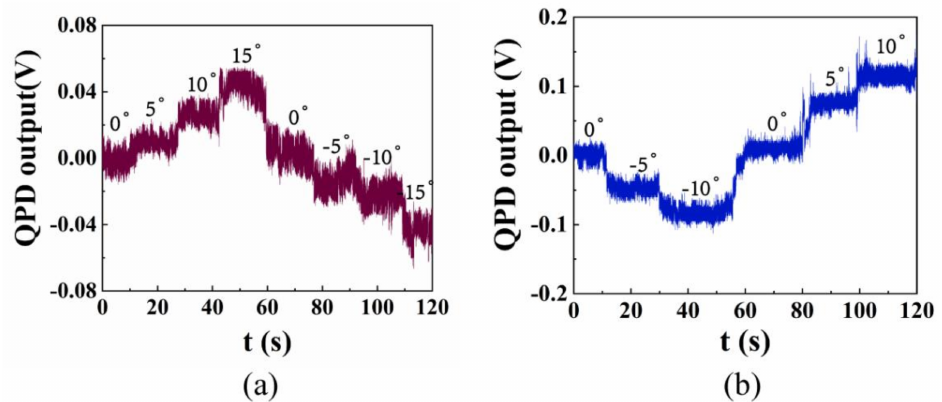
Figure 10. Signal of the optical force accelerometer. Variation of the output signal with the angle of platform changes along ( a ) the short axis and ( b ) the long axis of the elliptical beam.